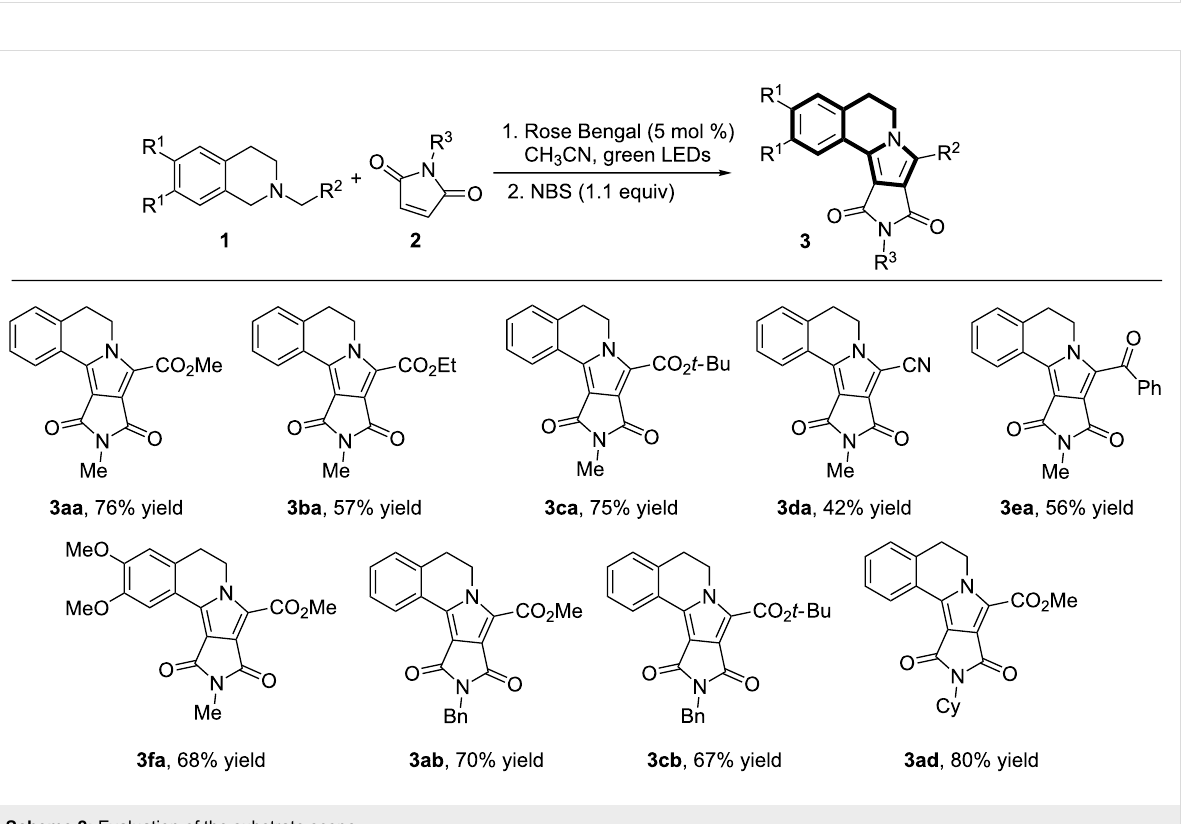
Scheme 2: Evaluation of the substrate